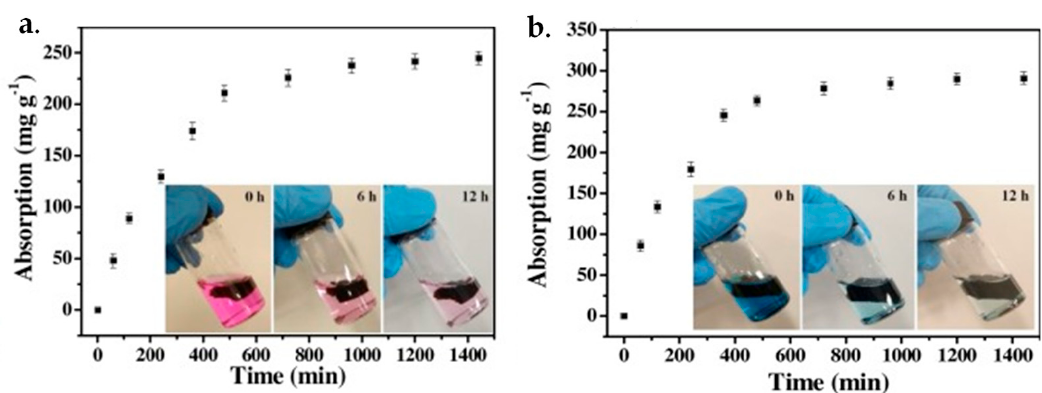
Figure 6. Applications of xanthan gum/graphene oxide (XG/GO-1) hybrid aerogels for organic dyes removal: ( a ) Adsorption of rhodamine B (RB). ( b ) Adsorption of methylene blue (MB). Reproduced from [183] , with permission from Elsevier, 2017.